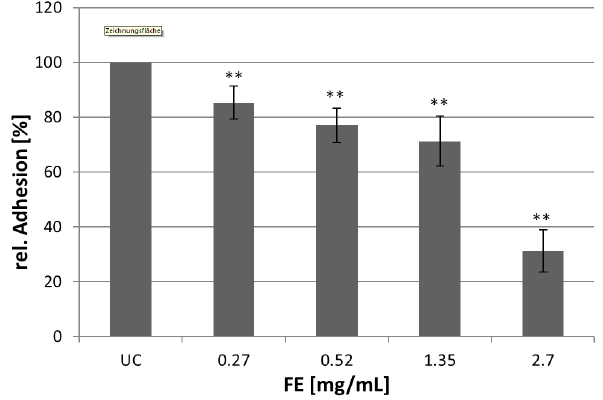
Figure 1. Relative adhesion (%, related to the untreated control UC) of FITC-labeled H. pylori to AGS cells after pretreatment of the bacteria with different concentrations of Okra FE. UC: untreated control; Values are mean 6 SD; n=3 independent experiments with 3 replicates each, ** p , 0.01.